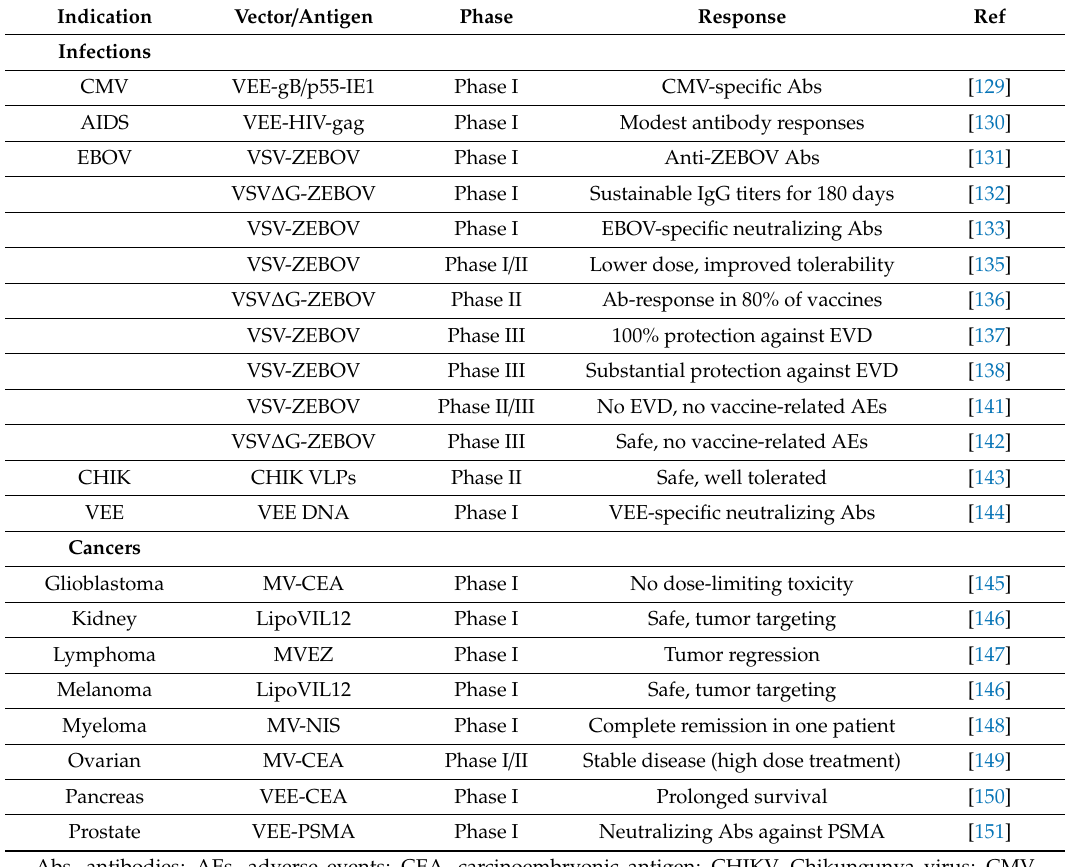
Table 3. Clinical trials conducted for self-amplifying RNA virus